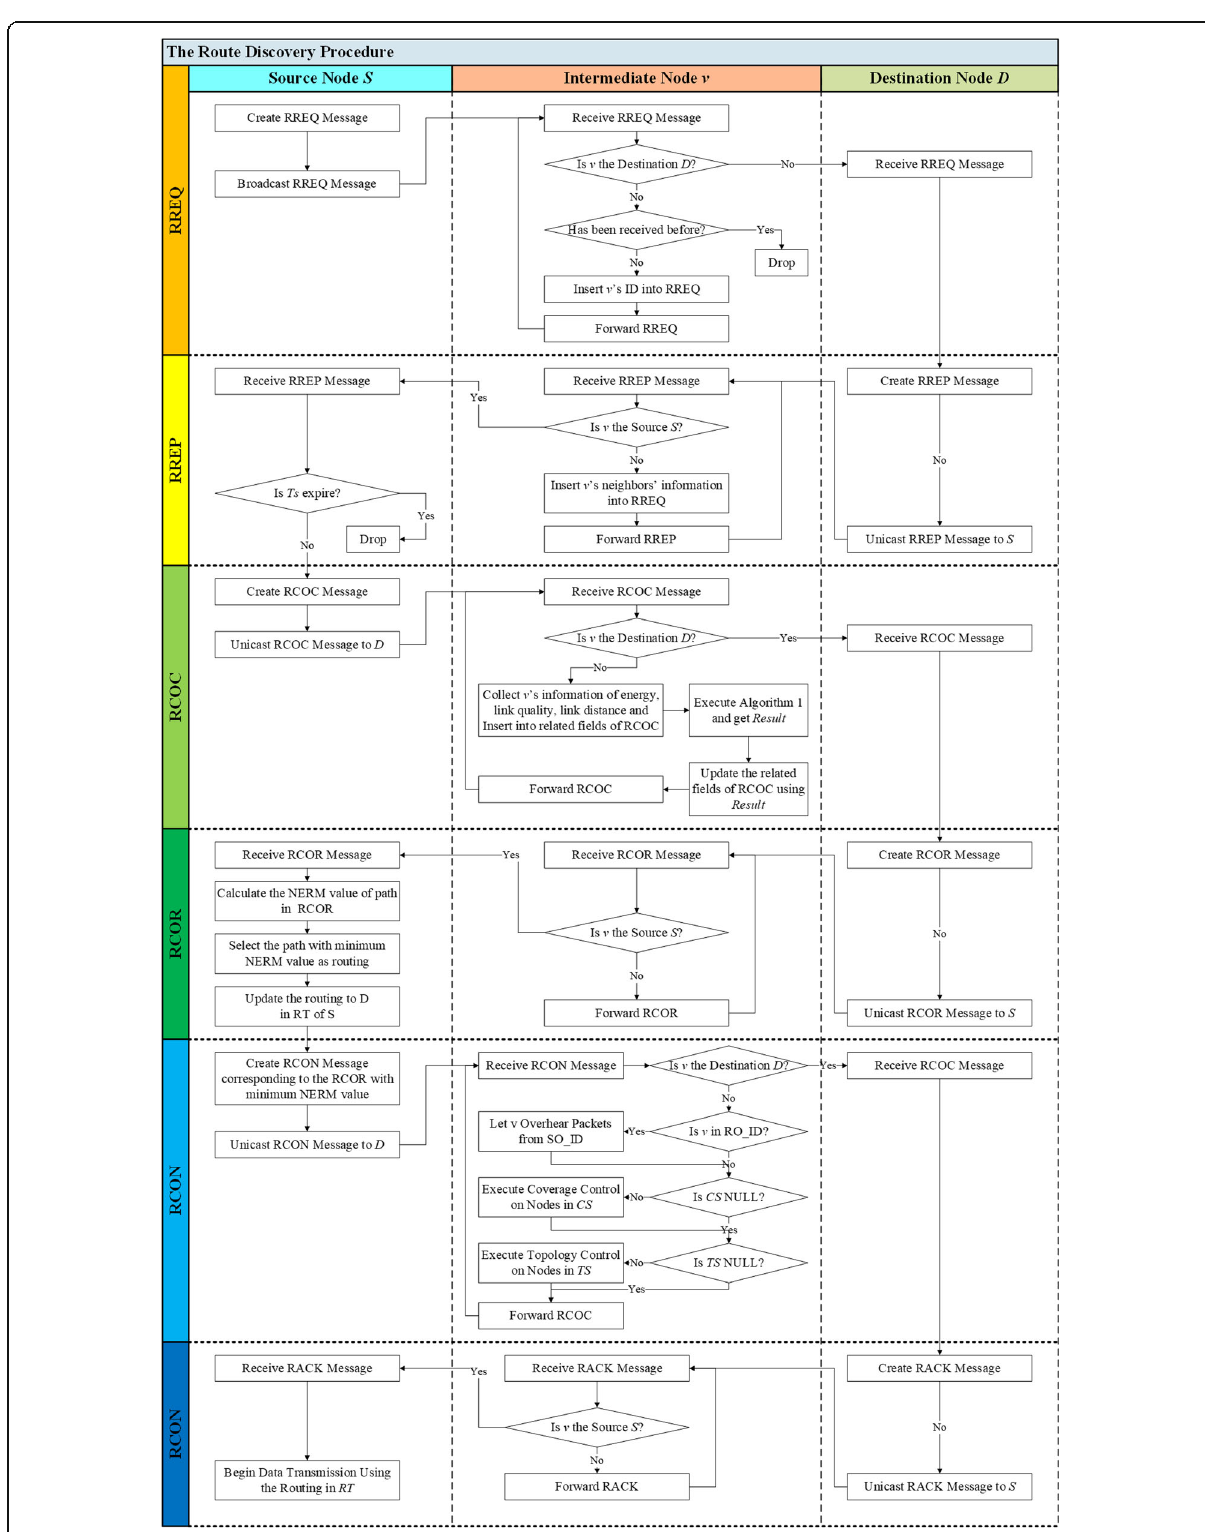
Fig. 18 The route discovery procedure of NAER. Figure 18 shows the six phases of route discovery procedure of NAER, including the flows charts of the messages transmitted among source node, intermediate node and destination